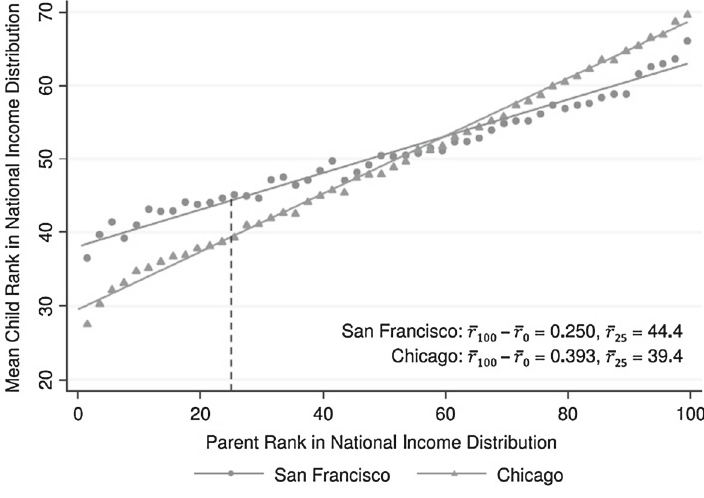
Fig. 1 Rank-rank regression in San Francisco and Chicago. (Source: Chetty et al.